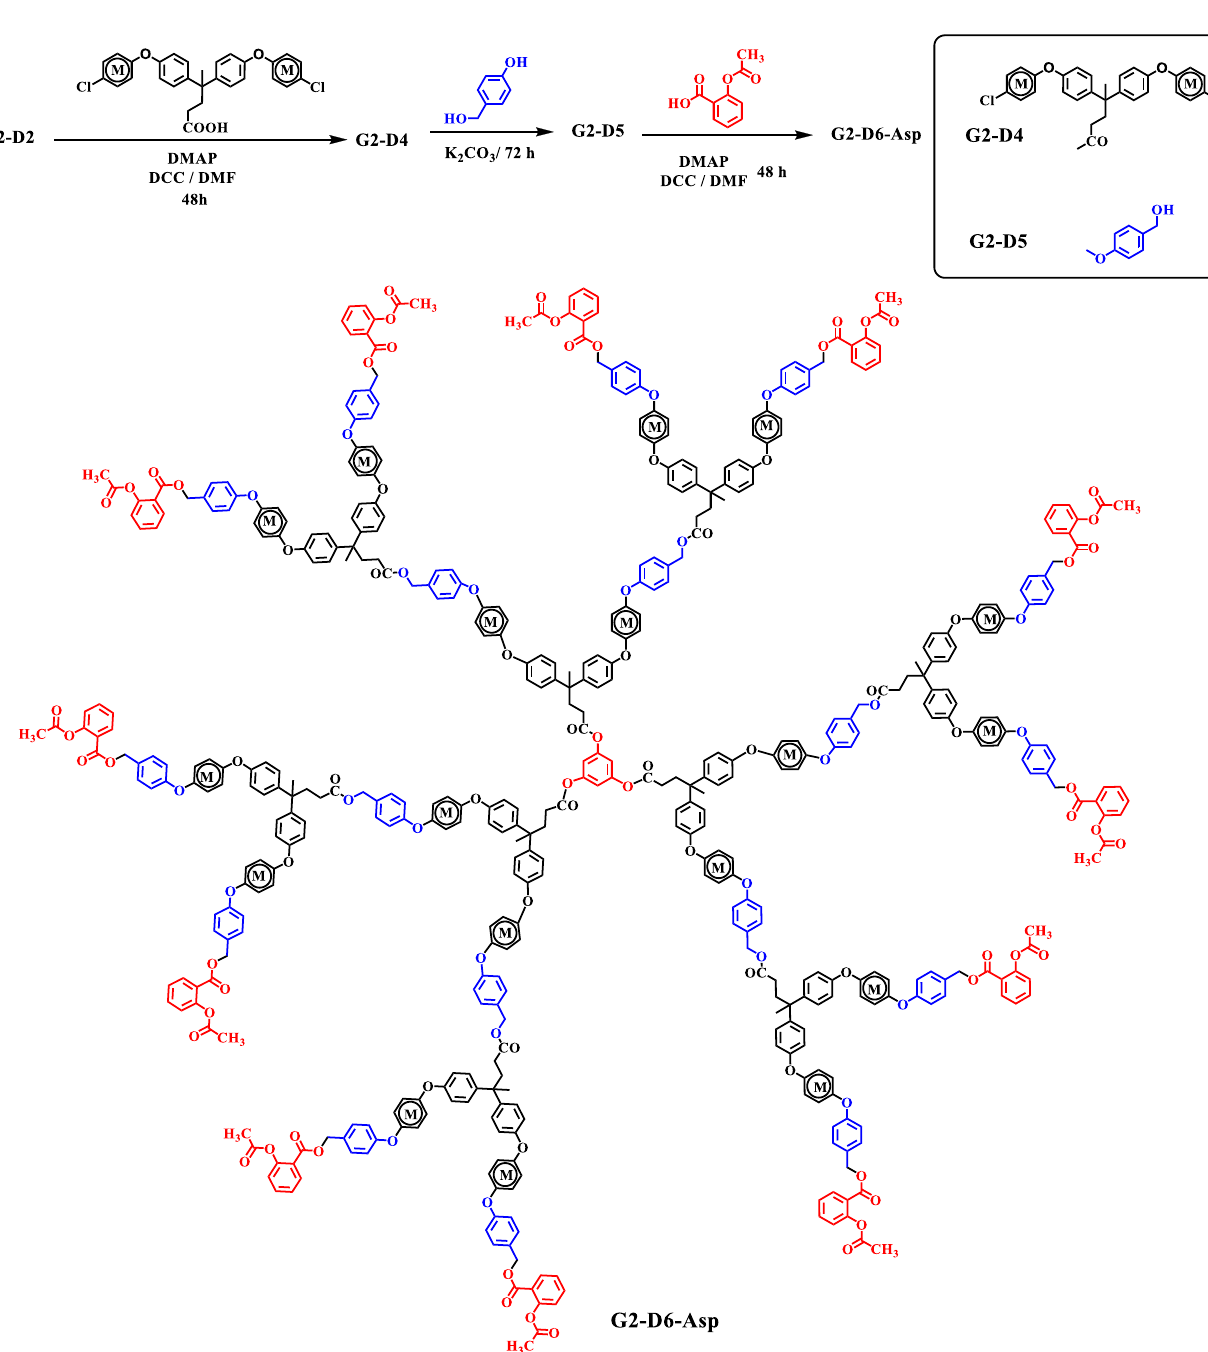
Scheme 2. Schematic representation of the synthesis of G2-D6-Asp.